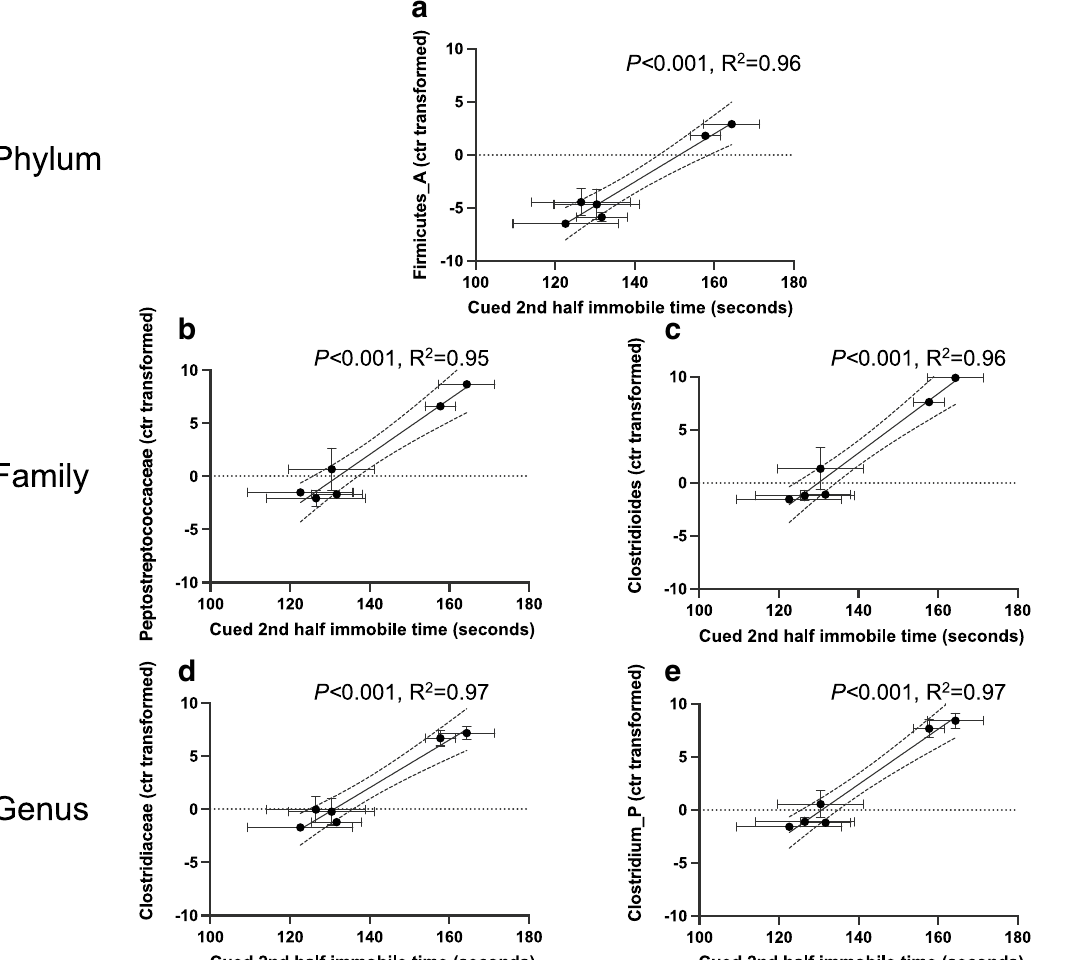
Figure 5. Specific bacterial taxonomic composition at 2 weeks old promoted cued fear retention. The relative abundance of Firmicute_A ( a ), Peptostreptococcaceae ( b ) and Clostridiaceae ( c ), Clostridioides ( d ) and Clostridium_P ( e ) in the fecal samples of 2 weeks old mice was significantly correlated with the immobile time in the second half of the cued fear conditioning test. Pearson’s correlation coefficient was considered significant at p <